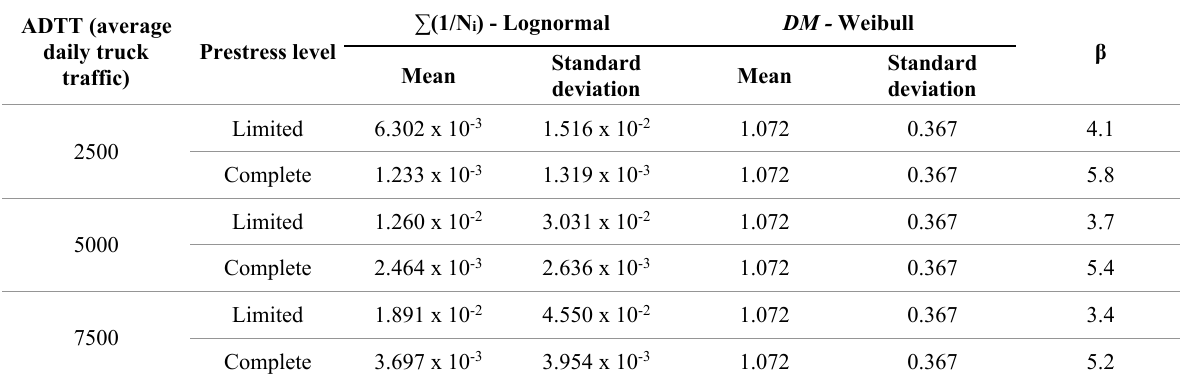
Table 7. Moments for dependent variables and reliability indexes (β) for prestressing steel (exterior girder) for design service life of 50 years.